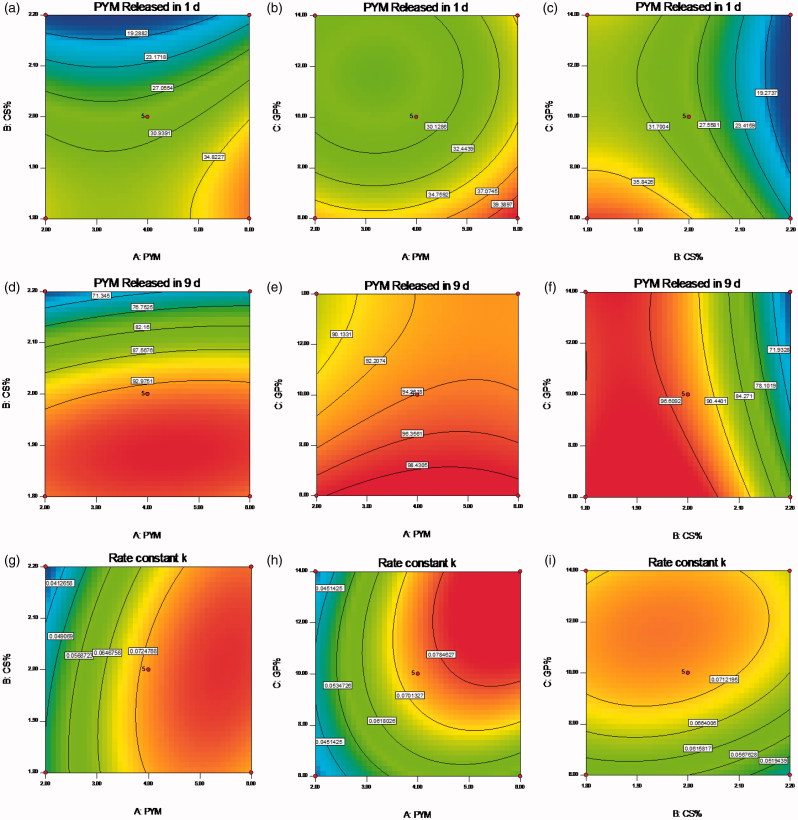
(a–i) Contour plots showed the effects of X1(A), X2(B) and X3(C) on the response Y1, Y2 and Y3. X1 is the factor of concentration of PYM, X2 is the factor of CS amount, X3 is the factor of GP content, Y1 is the response of cumulative release percentage of PYM in 1 day, Y2 is the response of cumulative release percentage of PYM in 9 days, Y3 is the response of rate constant k.